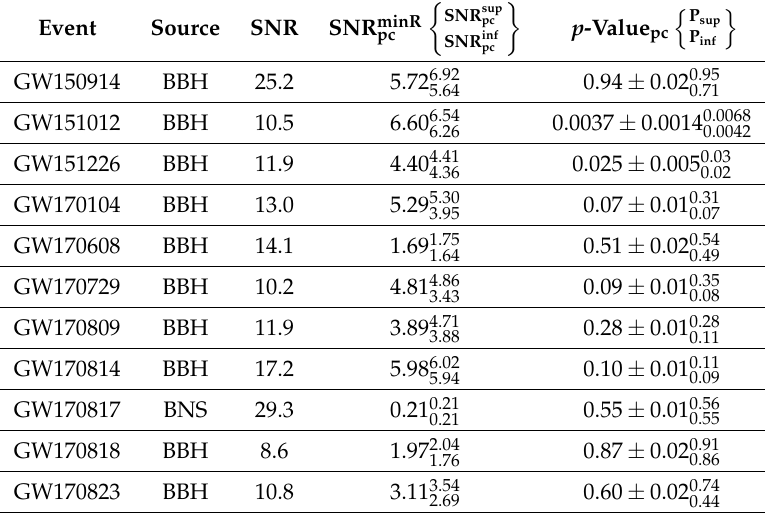
Table 13. p -values for post-coalescence deviations from GR obtained by cWB for the eleven GW events from GWTC-1 [25]. Post-coalescence SNR, SNR minR pc ; and estimated probability such that SNR minR pc produced by a noise fluctuation. Here P sup and P inf are refering to the probability of SNR inf pc and SNR sup pc , respectively. Event Source SNR SNR minR pc